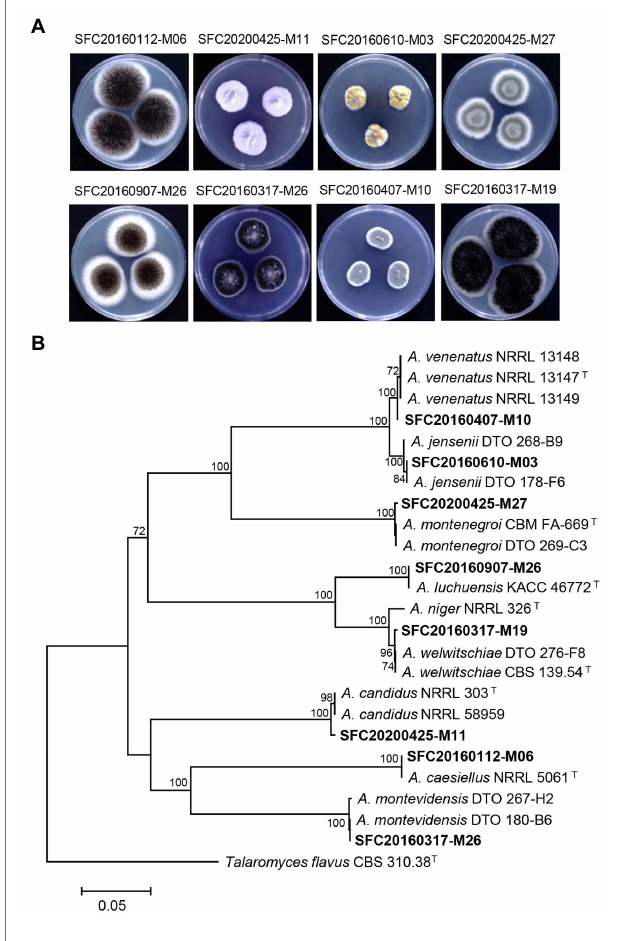
FIGURE 1 | The colony morphology (A) and phylogenetic tree (B) of eight Aspergillus strains isolated from different sites of the Korean coast. Aspergillus isolates were cultivated on potato dextrose agar medium at 25 ° C for 7 days. The calmodulin gene ( CaM )-based phylogenetic analysis was performed using a neighbor-joining method with 1,000 bootstrap samplings. Bootstrap scores (>70%) are presented at the nodes. The scale bar indicates the number of nucleotide substitutions per site. T indicates type